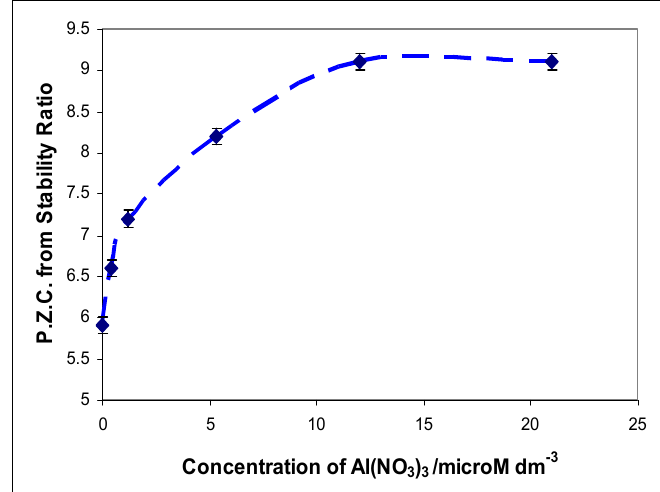
Figure 14. Variation of the p.z.c. of TiO plot is derived from results of Wiese and Healy [8]. The same group reports a p.z.c of 8.9 for γ